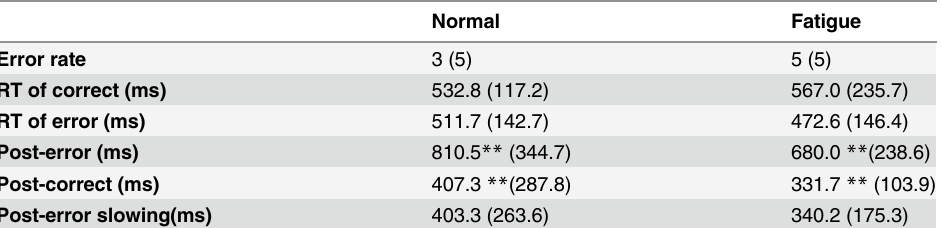
Table 1. Results of error rates, correct and erroneous RTs, and post-errors and post-corrects for the standard trials.